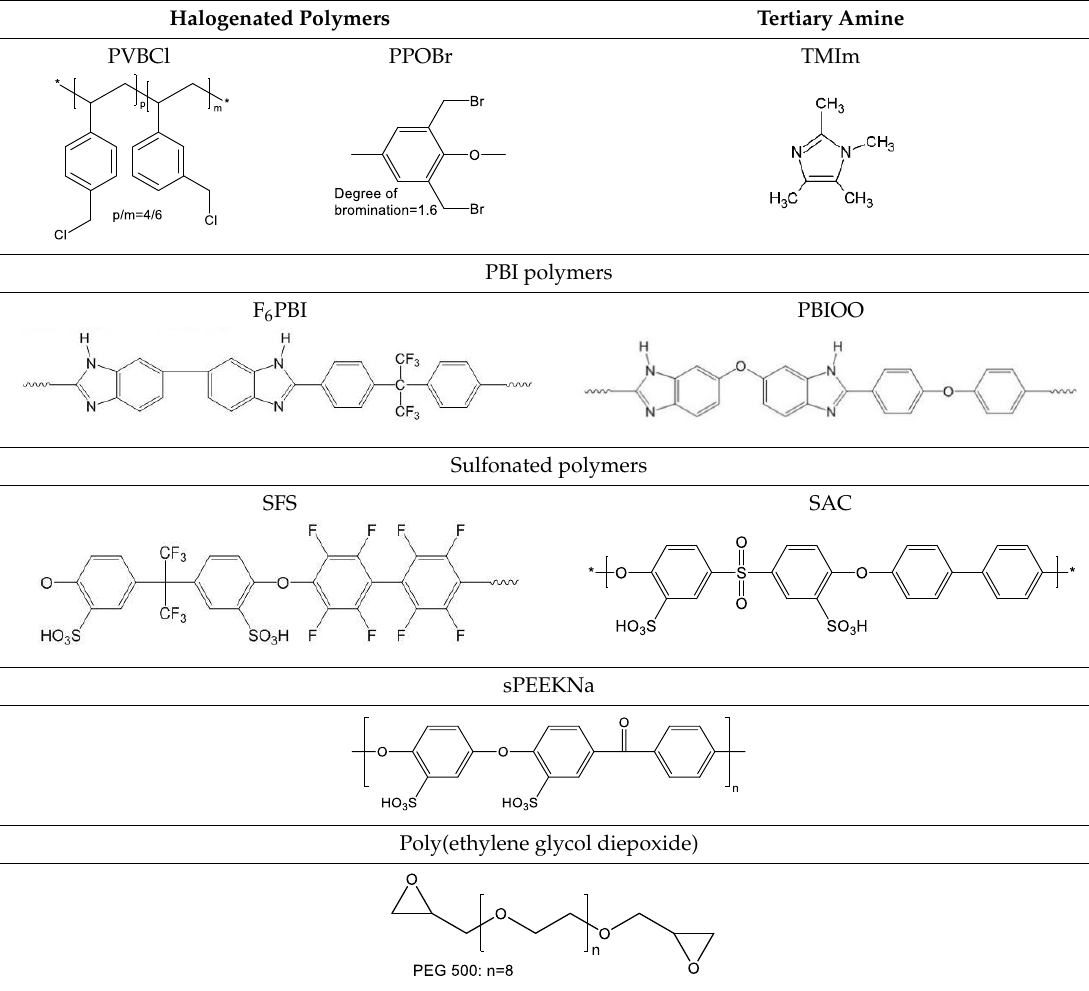
Table 3. Polymer components of the PBI-blended membranes.